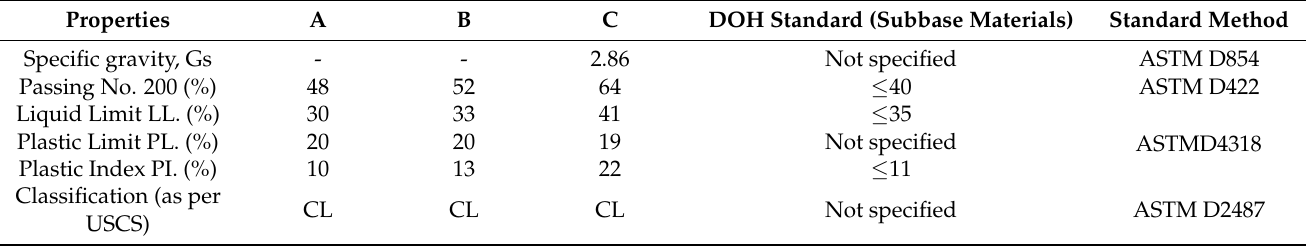
Table 4. The physical and engineering properties of lateritic